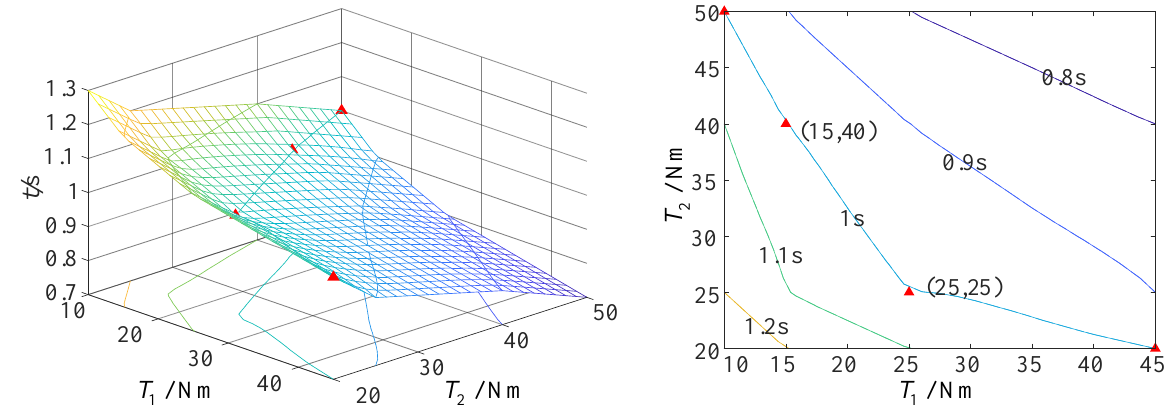
Figure 21. The curve of driving torque and deployment time of folding wing at an airspeed of 10 m/s (fixed-axis – non-fixed-axis stepwise deployment mode). When the fixed-axis – non-fixed-axis stepwise deployment mode is adopted and the airspeed is 20 m/s, the minimum driving torque required by axis 1 to complete the action is 25 Nm, and that required by axis 2 to complete the action is 20 Nm, on the premise that the folding wing can complete the action within 1 s, as shown in Figure 22.